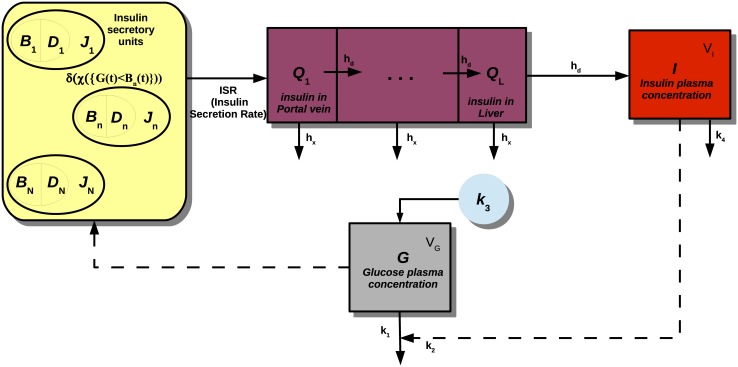
Scheme of the in vivo model.The pancreas releases at any given time a total quantity J(t) of insulin, sum of the amounts J
n(t) secreted by the single controllers (represented as circles), depending, for the n-th controller, on the threshold B
n(t) and on the potentiation level D
n(t). Insulin flows from the pancreas through the portal vein (Q
1 compartment) to the liver (Q
i compartments), from which a part of the hormone is lost. Insulin then reaches plasma (I is the plasmatic insulin compartment) and stimulates the uptake of glucose by tissues. Glycemia (G compartment) is raised by glucose hepatic production k
3 and high glucemias stimulate the production of insulin, closing the cycle.